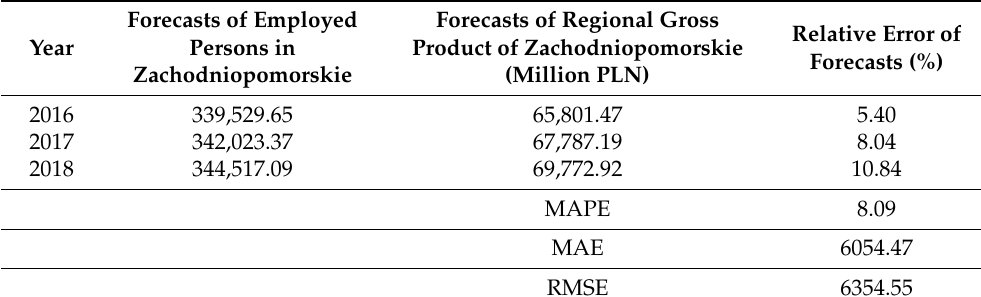
Table 6. Forecasts of employed persons (linear trend) and regional gross product of Zachodniopo- morskie voivodship (based on model 10).